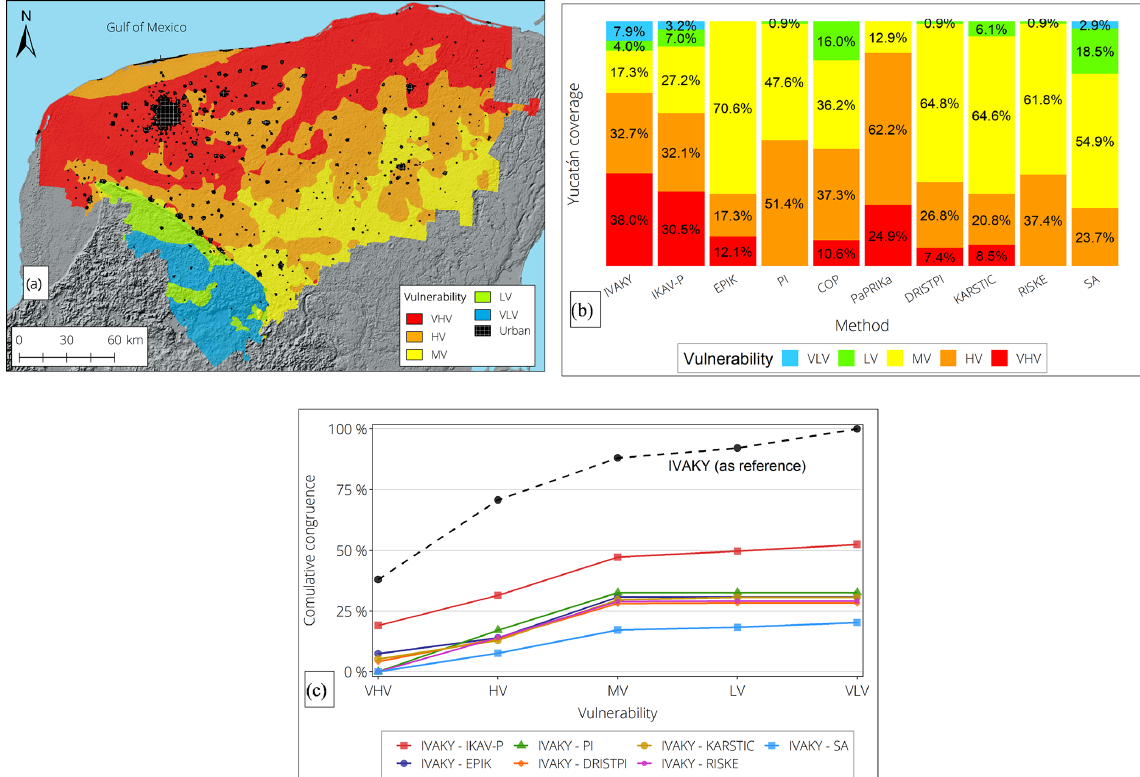
Figure 11. Validation of IKAV-P. (a) The intrinsic groundwater vulnerability map from the IVAKY method, digitalized from Aguilar-Duarte et al. (2016). (b) Comparison of stacked vulnerability percentages with IKAV-P and European methods previously applied in Yucatán. (c) The cumulative spatial correlation of vulnerability from IKAV-P and other methods previously applied in